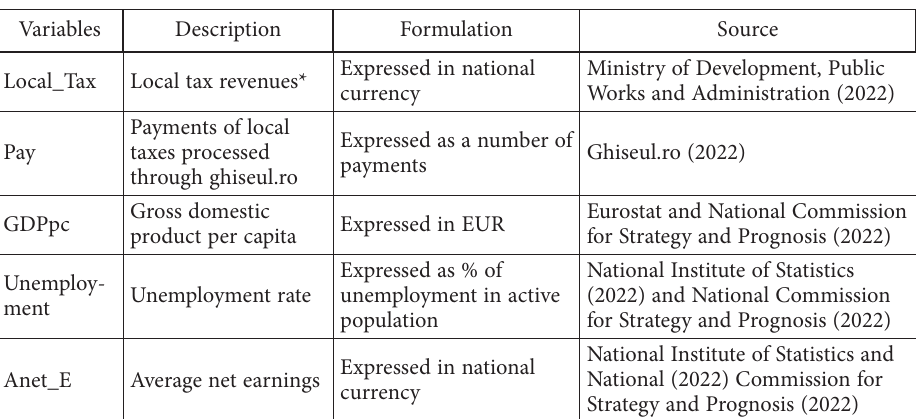
Table 1. Variables included in the panel